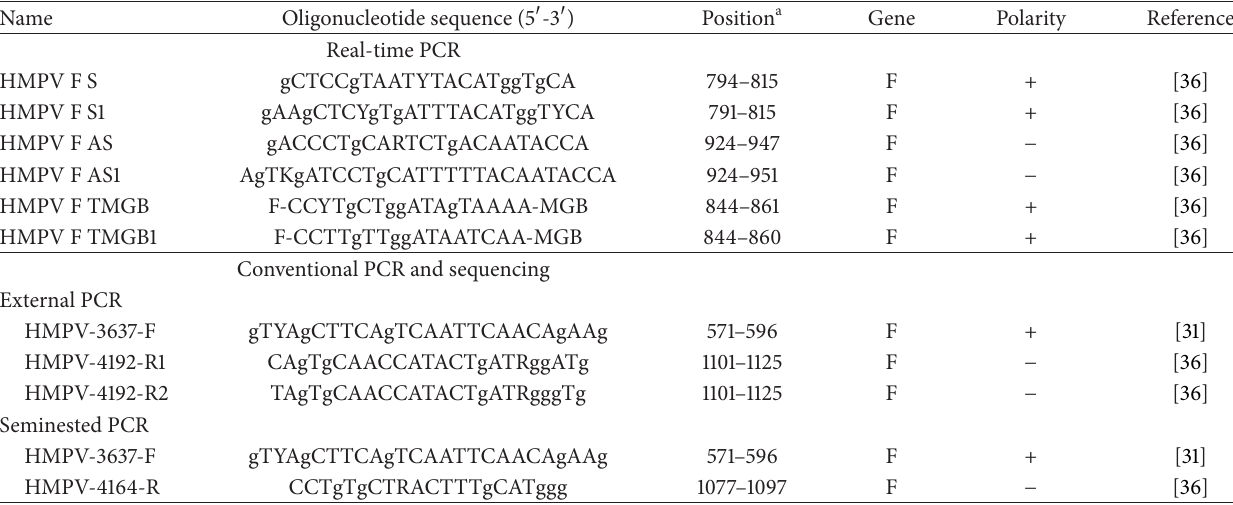
Table 2: HMPV oligonucleotide primers and probes.